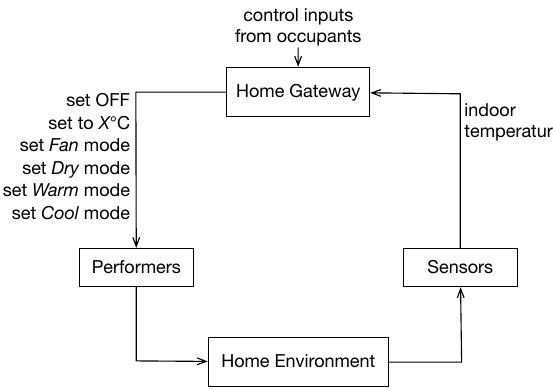
Figure 7. The safety control structure for indoor temperature